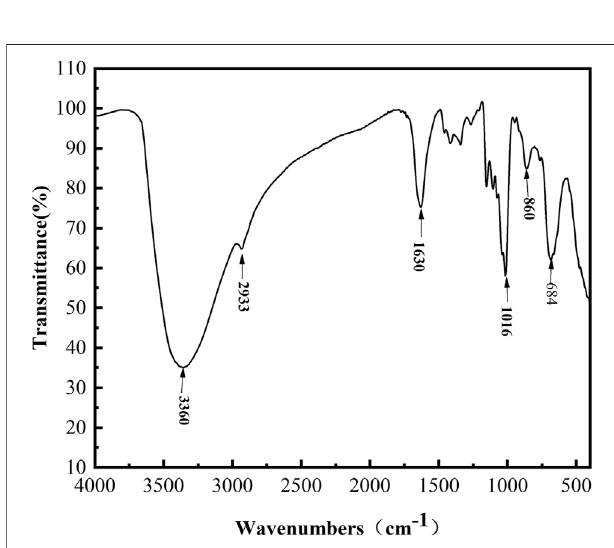
FIGURE 8 | FT-IR spectra of OL-dextran – iron